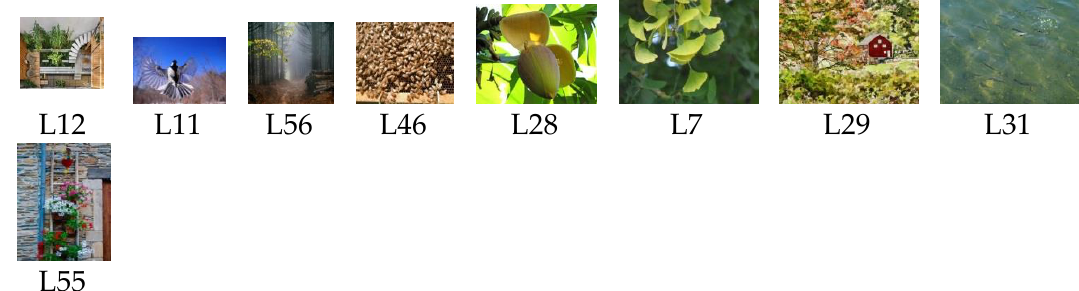
Figure 7. Most recommended pictures with all adjective grey relational coefficients >0.8.